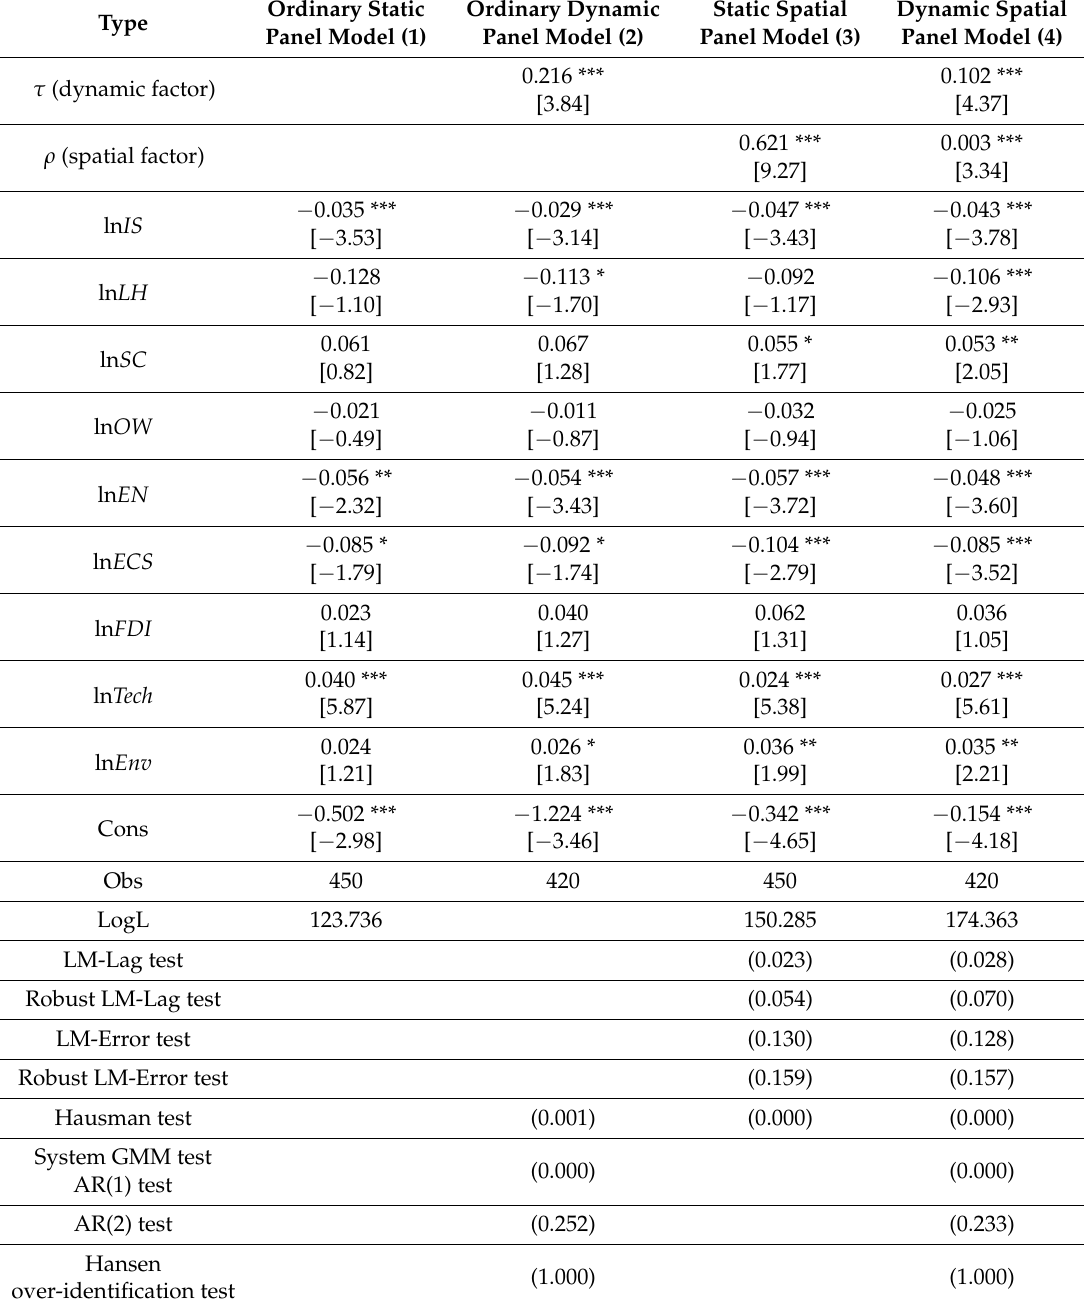
Table 5. Estimation results at the national level using the four